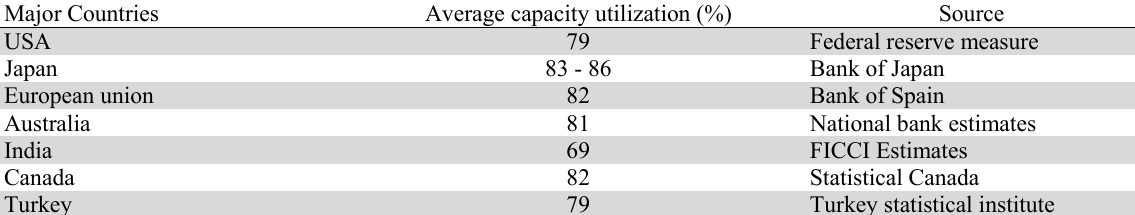
Average Utilization rates